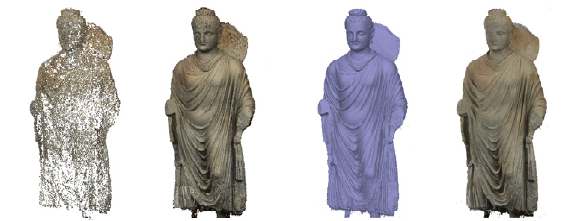
Figure 9 . Sparse, dense cloud, mesh model, textured model.